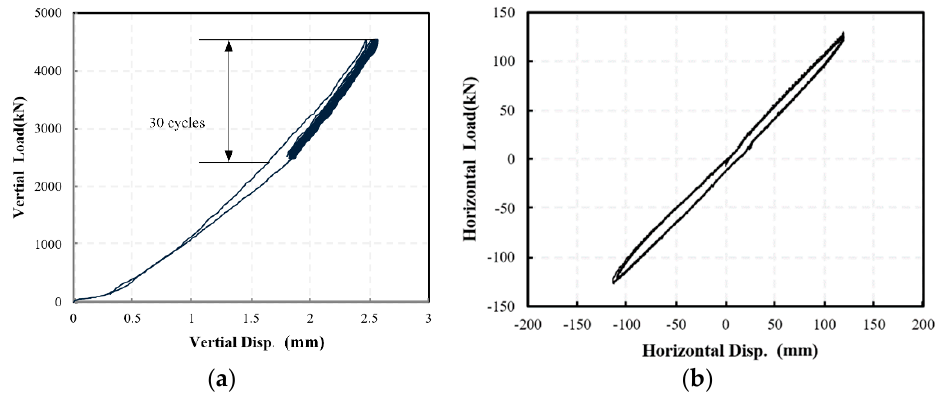
Figure 9. The force ‐ deformation curves of NRB ‐ 600 specimens in ( a ) vertical and ( b ) horizontal Figure 9. The force‑deformation curves of NRB‑600 specimens in ( a ) vertical and ( b ) horizontal direction.